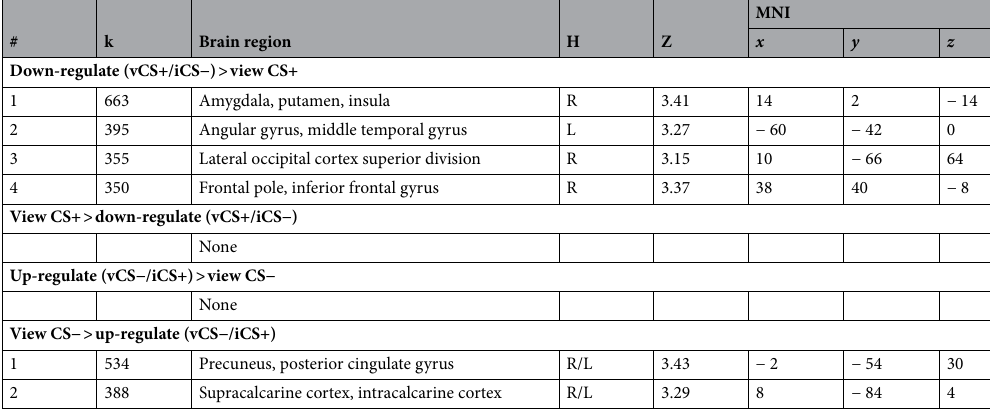
Table 5. Psychophysiological interaction model with right anterior insula seed during regulation phase. # = the number of a cluster, ordered by size; k = the number of contiguous voxels in the cluster; Brain region = the region of local maxima included in the broader cluster. The region names are taken from the Harvard–Oxford atlas in FSL; H = principal hemisphere of the cluster, right (R) or left (L); Z = maximum z-value from the cluster within the given brain region; MNI(X,Y,Z) = coordinates of the voxel with the maximum effect in the standardized space of the Montreal Neurological Institute (MNI), represented in units of millimeters (mm). All whole-brain unthresholded group-level maps can be viewed at neurovault.org (see